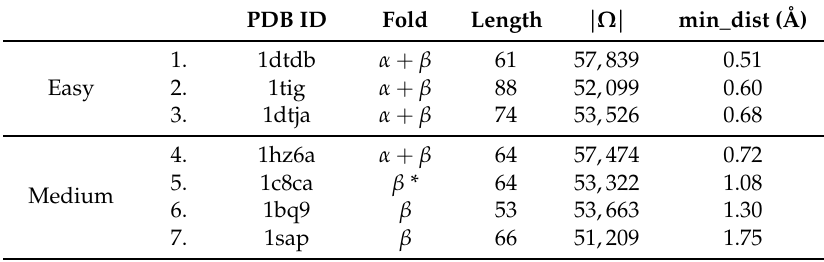
Table 1. Testing dataset (* denotes proteins with a predominant β fold and a short helix). Column 2 shows the PDB ID of a known native structure for each protein. Columns 3 and 4 show the fold and the length (in terms of the number of amino acids), respectively. Column 5 shows the actual size of the decoy set Ω generated via Rosetta for each target protein. Column 6 shows the lowest lRMSD, among all decoys, from the known native